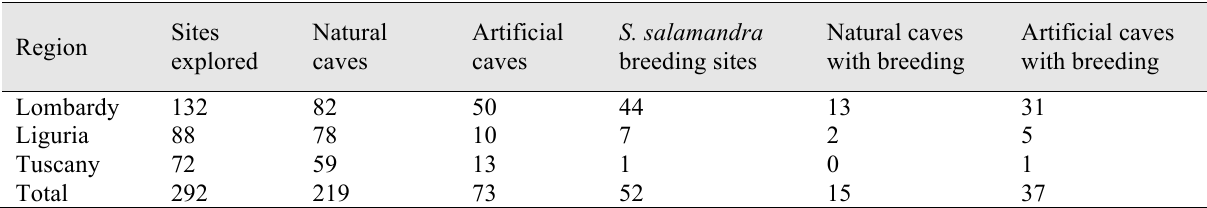
Table. 1. Results of cave surveys performed from 2008 to 2017 in